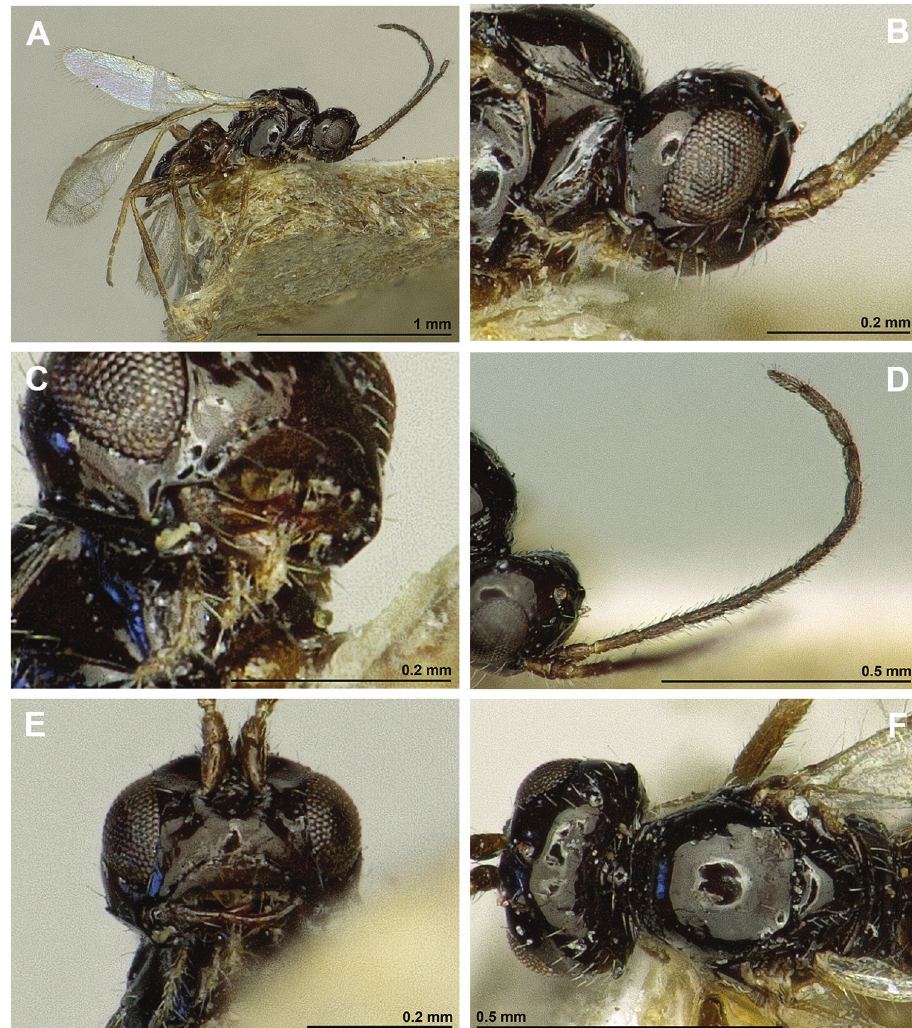
Figure 5. Hoplocrotaphus mysteriosus Fischer, 1971 (female, holotype) A Habitus, lateral view B Head, lateral view C Mandible D Antenna E Head, front view F Head and mesoscutum, dorsal view. Comparative diagnosis. This species is similar to H. mongolicus Fischer; differ- ences between both species are described under the latter